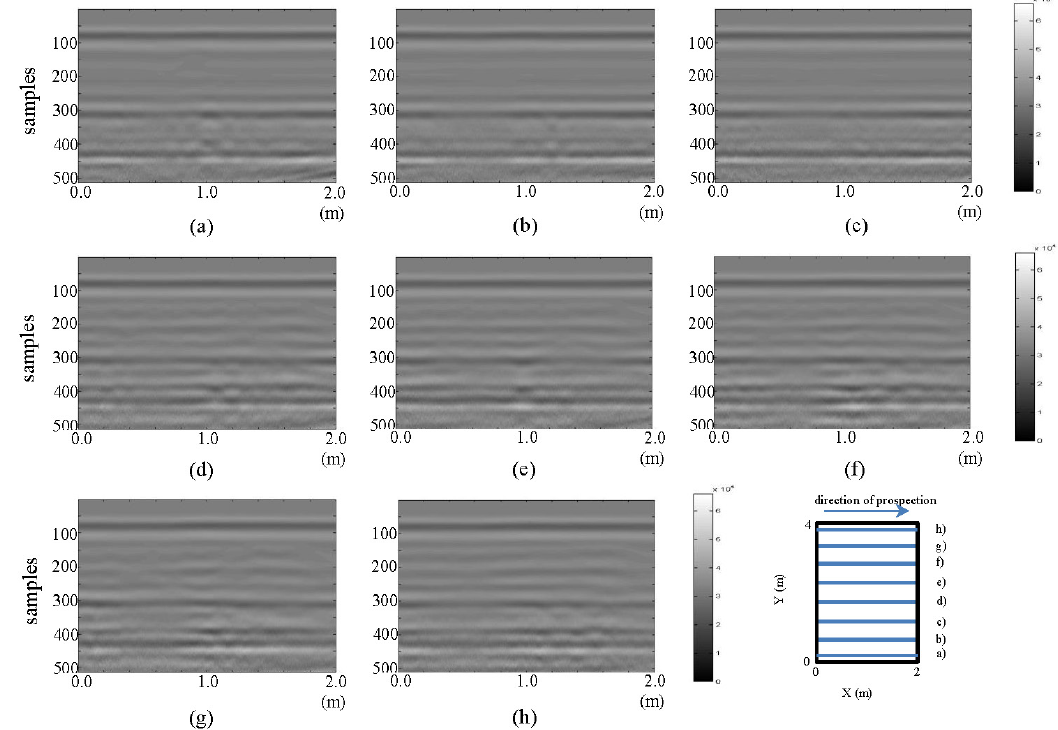
Figure 22. Horizontal profiles: raw images. ( a – h ) are profiles sf1 to sf8,